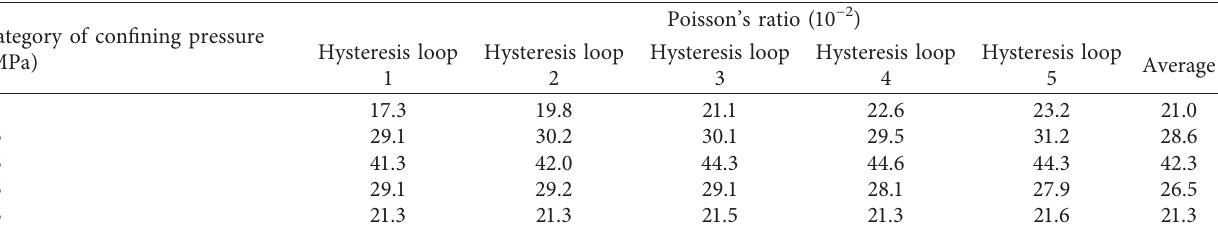
Table 6: Poisson’s ratio of hysteresis loops under various confining